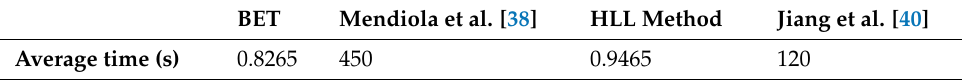
Table 5. Time in seconds to segment a volume with 5 and 60 slices using different